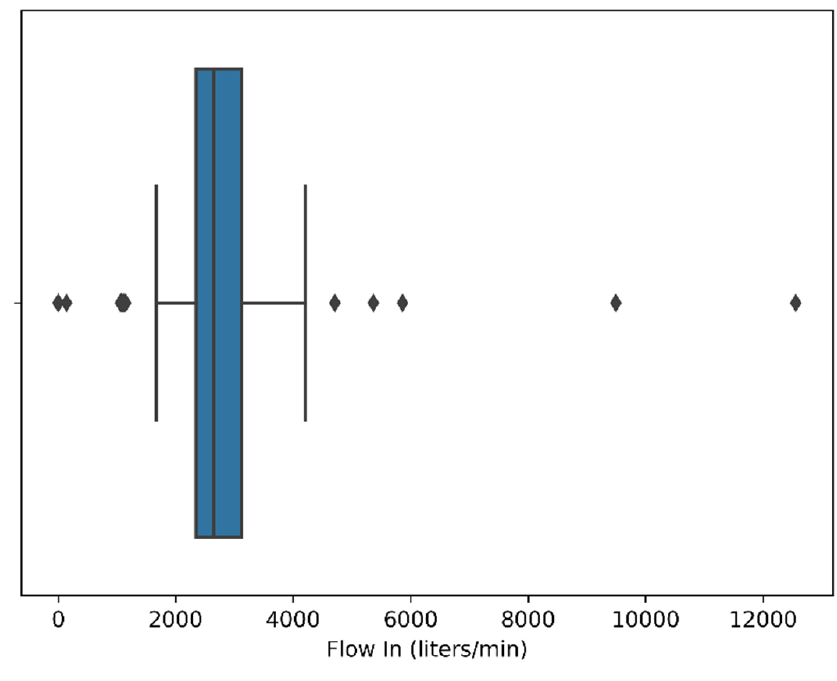
Figure 10. Flow In boxplot .